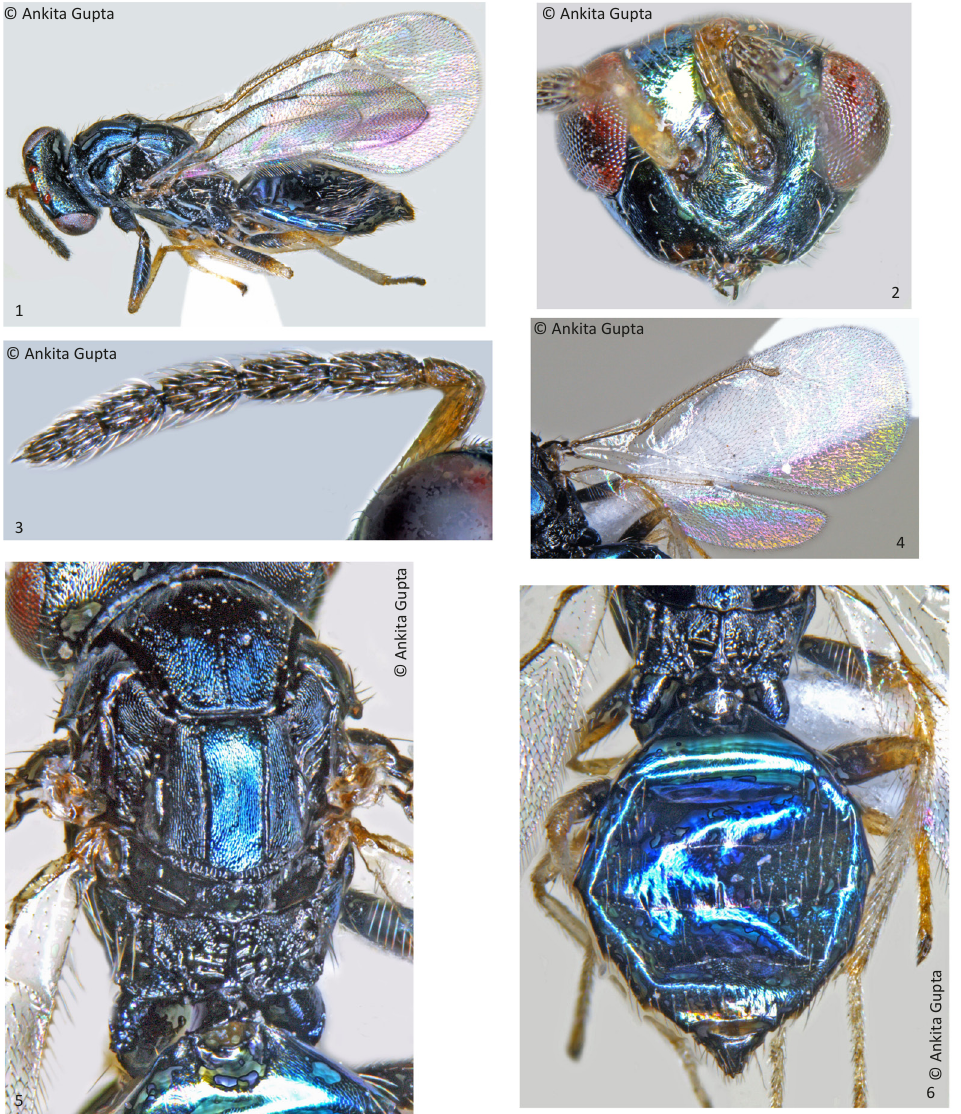
Images 1−6. Tetrastichus bilgiricus female 1 - Female, profile view; 2 - Head in frontal view; 3 - Antenna; 4 - Wings; 5 - Mesosoma; 6 - Propodeum with